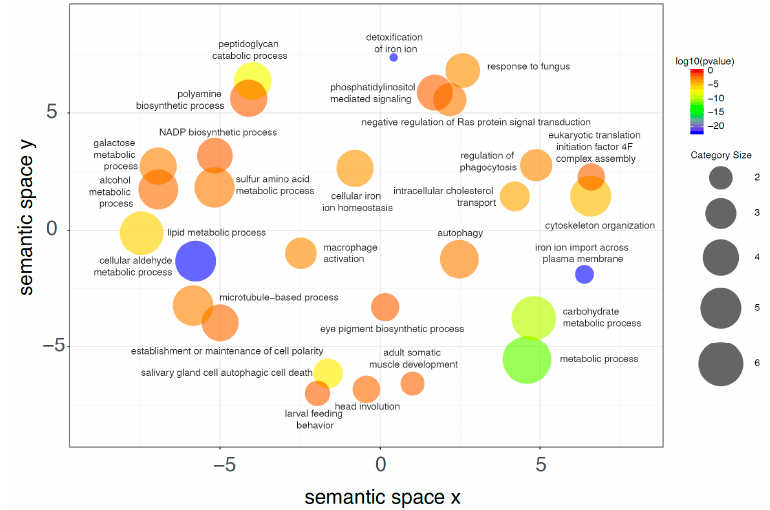
Figure 8. Downregulated genes associated to the GO category “Biological Processes”. Starting from the enrichment analysis of genes that are downregulated in midguts of larvae reared on VMD compared to SD, REVIGO was used to group similar biological processes on the basis of the SimRel semantic similarity metric; in this way categories with similar descriptions are close in the plot. As shown in the scale on the right, the color of the bubble identifying each biological process is a function of log 10 ( p value) for the false discovery rate for the enrichment of each process. Bubble size indicates the frequency of each GO term (larger size indicates larger categories) and was calculated by REVIGO on the basis of the size of each category in a background database (SwissProt [42]). Only categories with FDR ≤ 1.0 × 10 − 3 were selected, see full list in Supplementary Tables